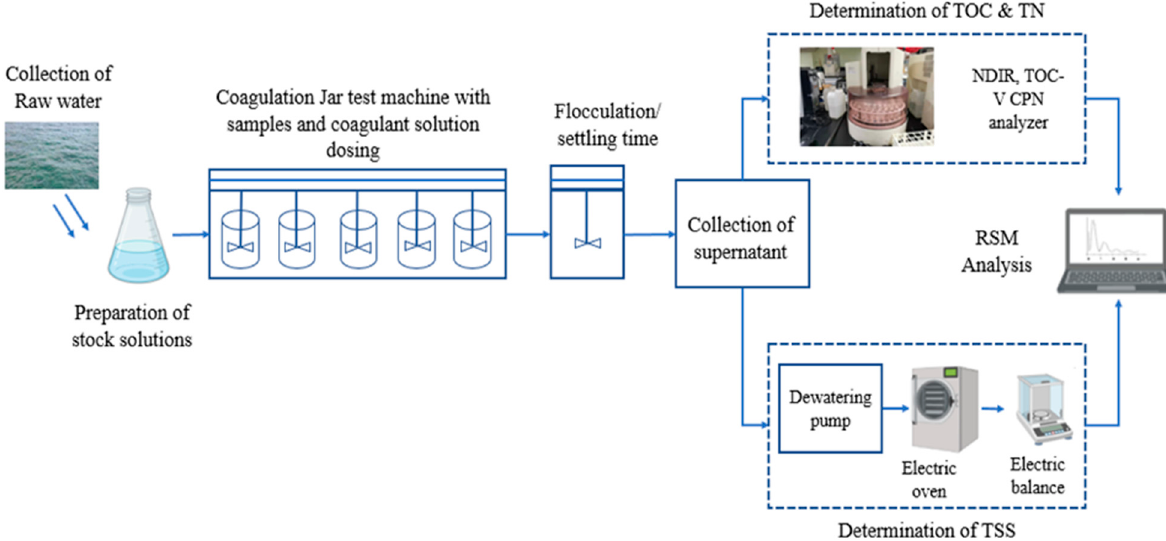
Figure 1. Schematic illustration of the experimental setup.